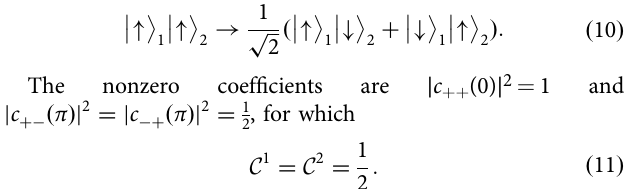
direct transition from C 1 þ C 2 ¼ 2 to C 1 þ C 2 ¼ 0 at the solution Þ = f ð π Þ ¼ ~ r ¼ ð H þ M Þ = f ð 0 Þ . of ð H (cid:3) M 2 1 $ σ 2 when M 1 = M 2 ≡ M in Eq. (4), the corresponding to σ 1 (cid:4) (cid:4) (cid:5) (cid:5) z z (cid:4) (cid:4) " ground state at the north pole with θ = 0, is " provided 1 2 that ~ rf ð 0 Þ < H þ M . At the south pole with θ = π , the ground (cid:4) (cid:4) (cid:5) (cid:5) (cid:4) (cid:4) # for ~ rf ð π Þ < H (cid:3) M , but it is degenerate between state is # 1 2 the antialigned con fi gurations for ~ rf ð π Þ >H (cid:3) M . In that case, the